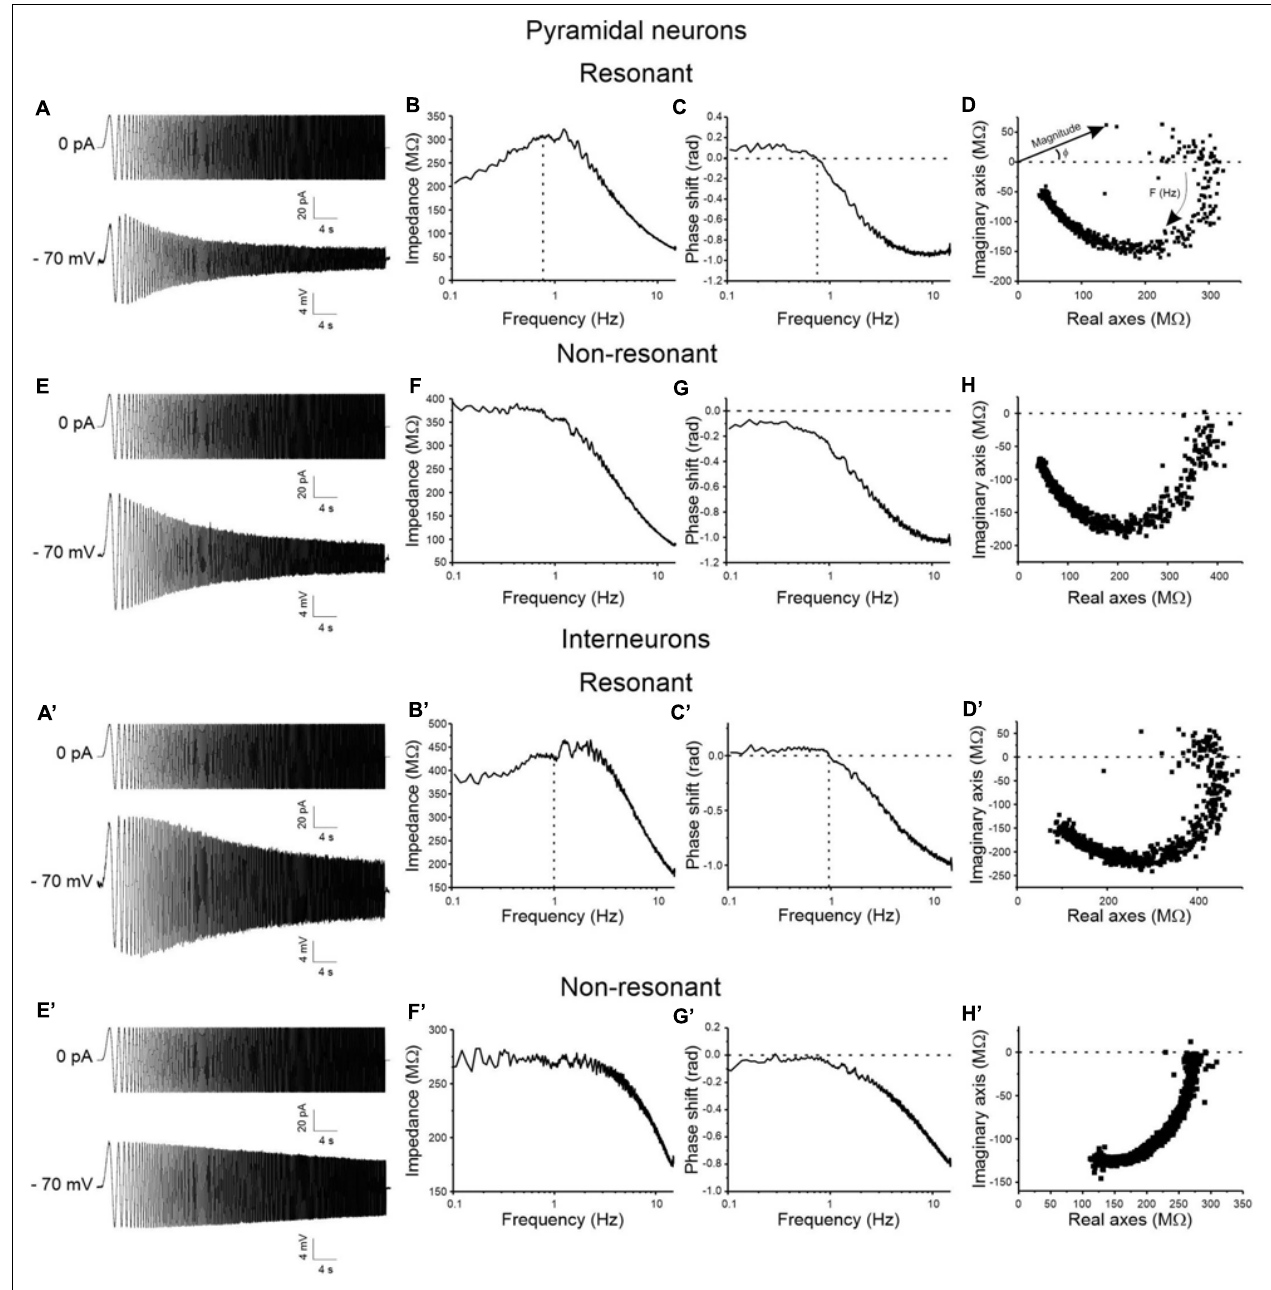
FIGURE 2 | Resonant vs. non-resonant behavior of pyramidal neurons (A–H) and GABAergic interneurons (A (cid:48) –H (cid:48) ) of the PRC. (A) Representative voltage response of a resonant pyramidal neuron (lower trace) to a ZAP input of linearly increasing frequency from 0 to 15 Hz (upper trace) at membrane potential of –70 mV. (B) Impedance magnitude vs. frequency relationship of the same cell as in (A) . Dashed line in correspondence to the peak in the relationship indicates the F res of the cell. (C) Impedance phase vs. frequency relationship of the same cell as in (A) . The resonant behavior of the cell determines a positive phase shift at the low frequencies, reflecting anticipation of the voltage wave relative to the current wave. Hence, F res corresponds to the value of frequency at which phase shift is 0 rad (dashed lines). (D) Complex representation of impedance of the same neuron shown in (A–C) . Impedance vectors are represented as points in the complex plane: the length of the vectors connecting the origin of the axes to each point of the graph corresponds to the impedance magnitude and the angle between each vector and the real axis corresponds to the impedance phase. Note that for resonant cells the complex representation is characterized by points in both positive and negative regions of the imaginary axis. (E–H) Same as (A–D) , for a representative non-resonant pyramidal neuron. The non-resonant behavior of the cell is evidenced by the absence of the peak in the impedance-to-frequency relationship (F) , the negative phase shift at all investigated frequencies (G) , and the points limited to the negative imaginary region of the impedance locus diagram (H) . (A (cid:48) –H (cid:48) ) Same as (A–H) for a representative resonant (A (cid:48) –D (cid:48) ) and a representative non-resonant (E (cid:48) –H (cid:48) ) GABAergic interneuron.